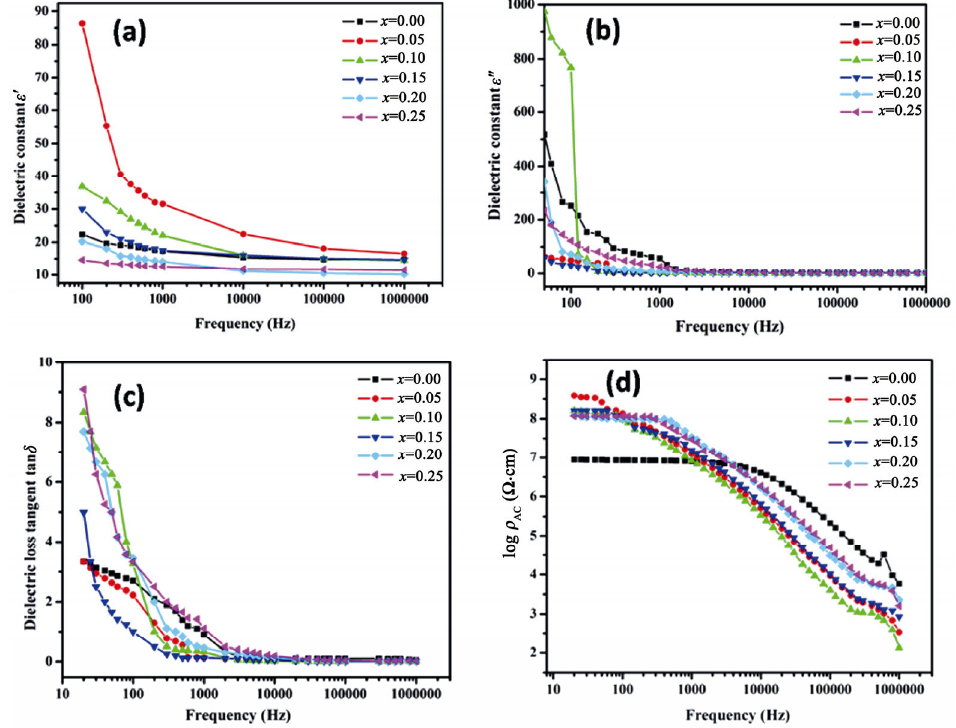
Fig. 6 Dielectric properties of the ferrites as a function of frequency: (a) dielectric constant  , (b) complex dielectric constant  , (c) dielectric loss tangent tan  , and (d) AC resistivity